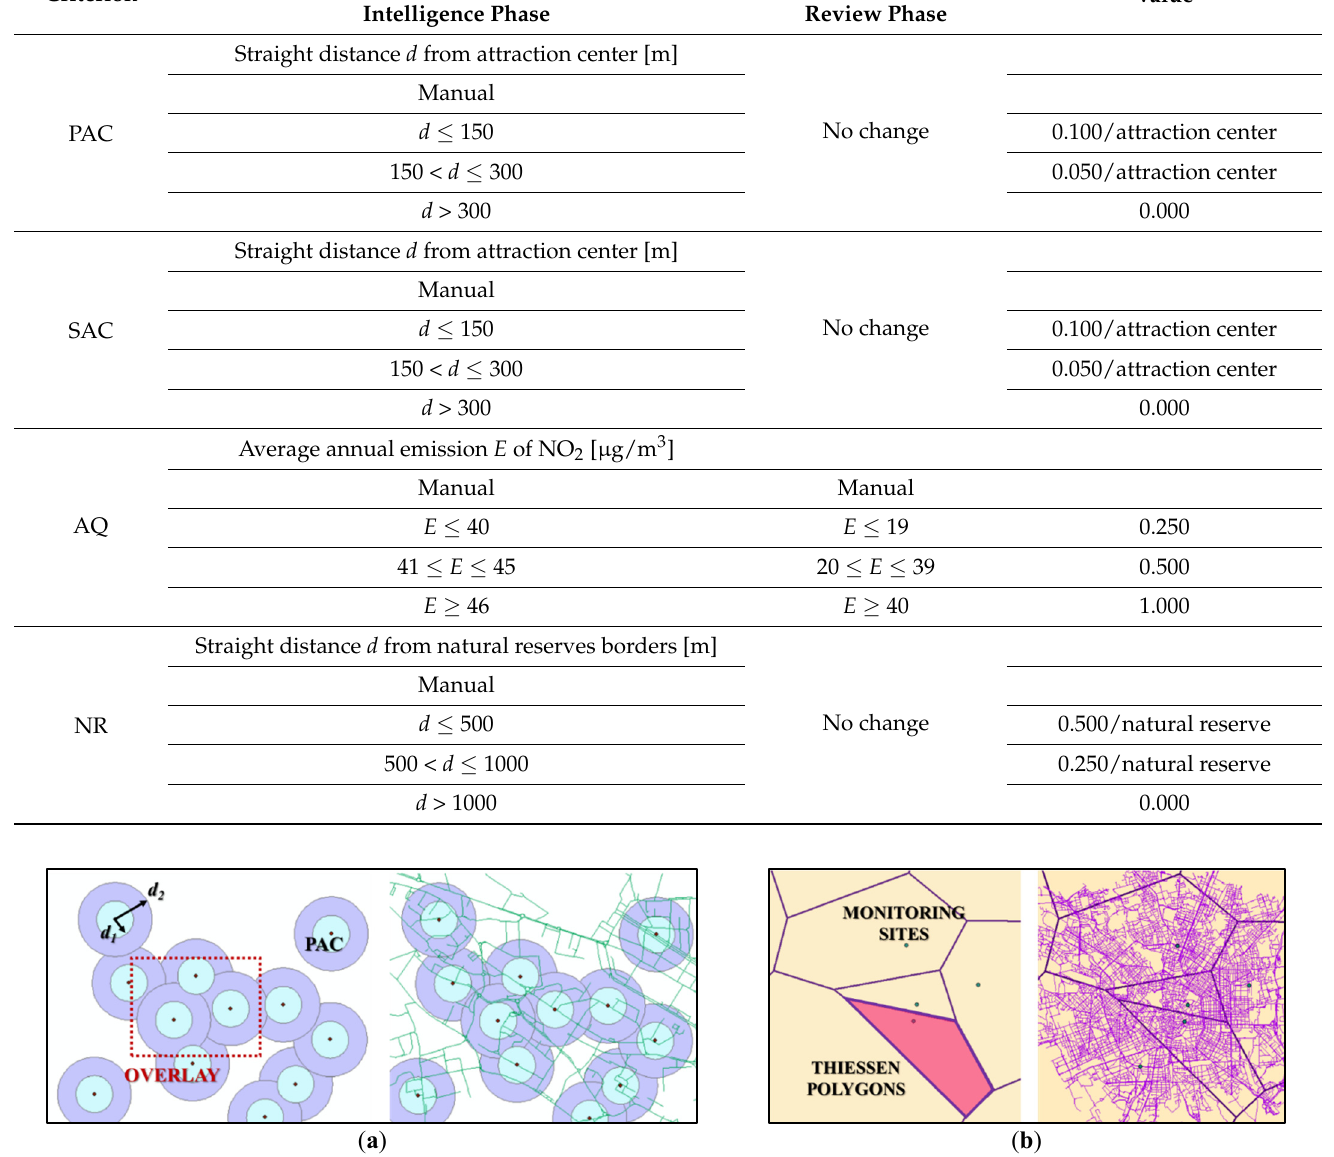
Figure 5. Data processing methodology ( a ) Multiple Ring Buffer; ( b ) Areal—Thiessen Polygon. The criteria maps are reported in Table 3: green-colored roads are characterized by higher parameters values, while dark red-colored roads show lower values. The four intervals (as shown in the legend) were obtained using the previously mentioned Jenks natural breaks classification